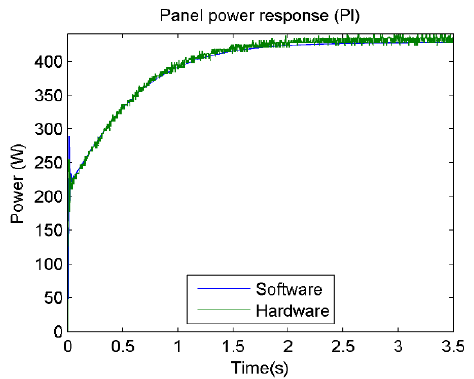
Figure 30. PVPE power response with PI CSE.